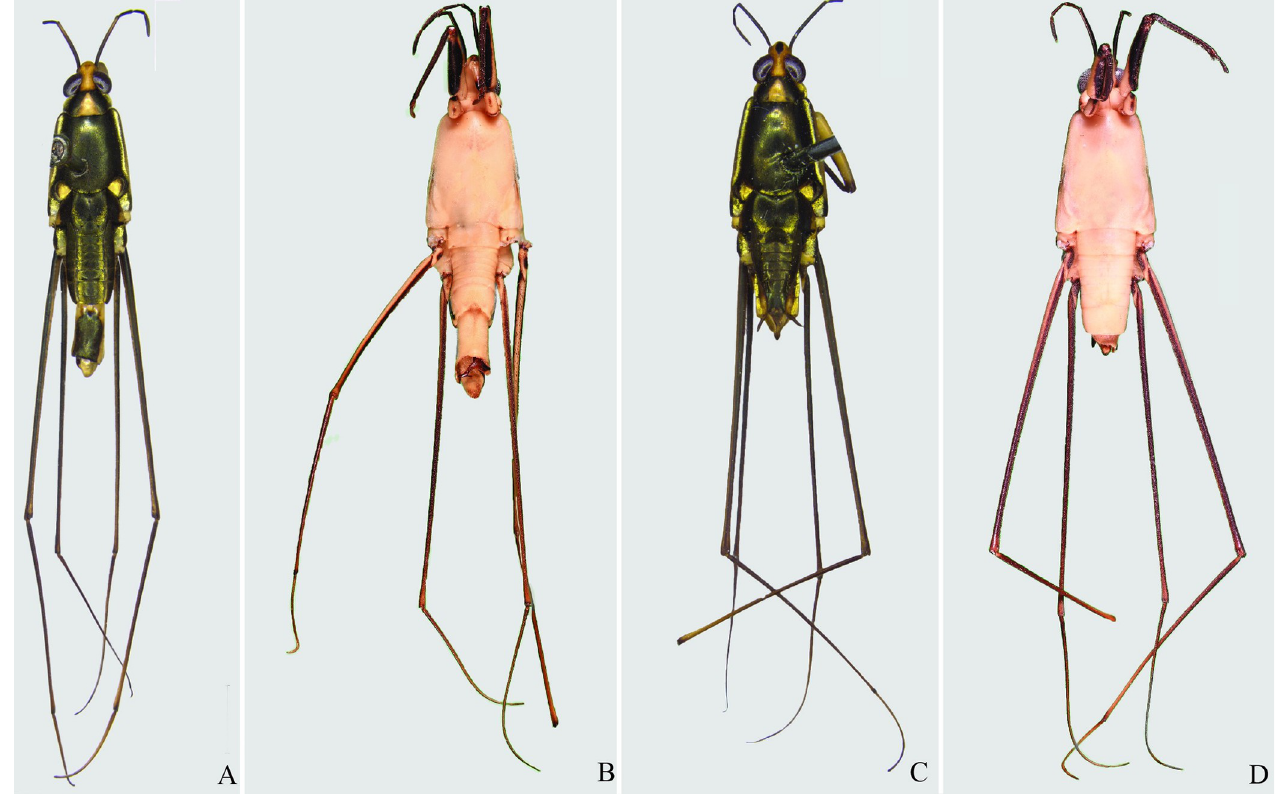
Fig 41. Potamobates variabilis . (A) Male, dorsal view; (B) male, ventral view; (C) female, dorsal view; (D) female, ventral view.